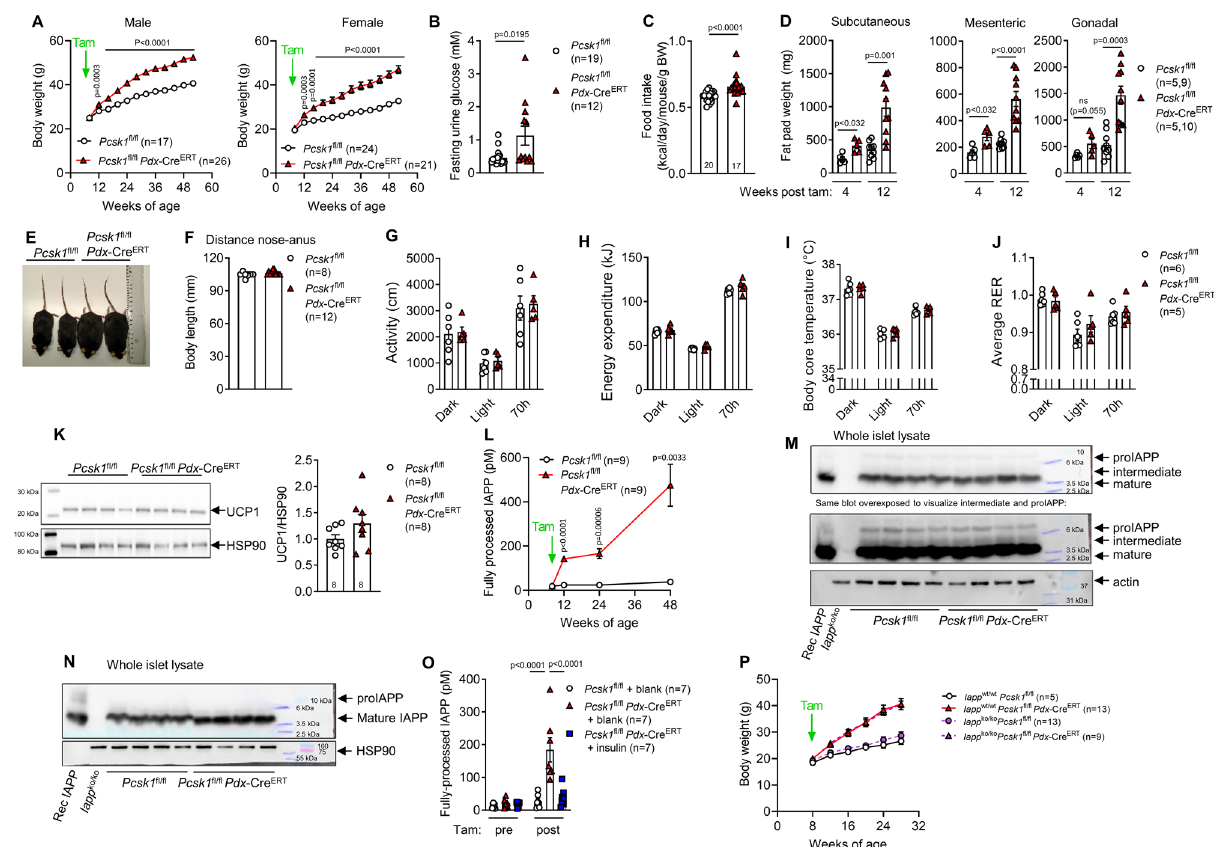
Fig. 4 | De fi ciency in proinsulin processing mediates hyperphagic